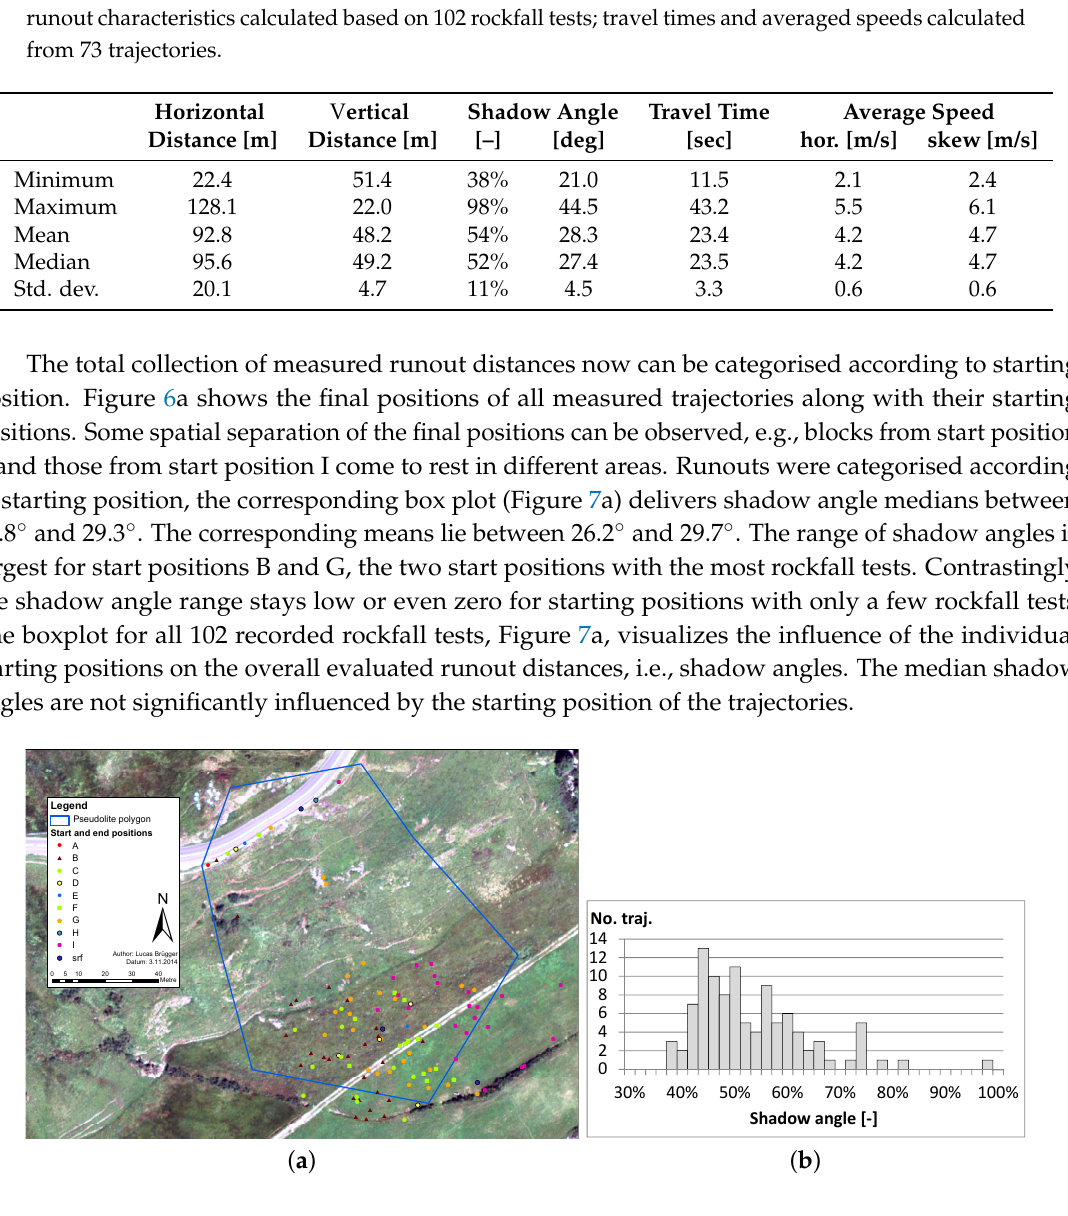
Figure 6. ( a ) Start and end positions of trajectories sorted according to their starting point. ( b ) Distribution of obtained shadow angles in 2%